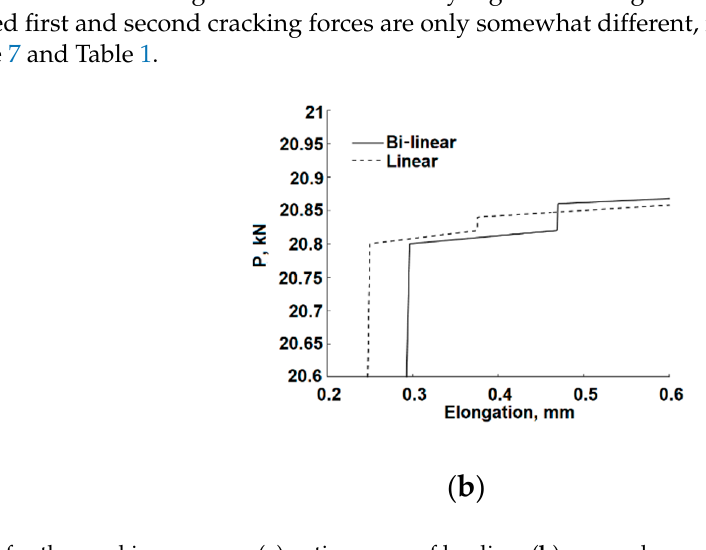
Figure 10. Bar elongation for the cracking process. ( a ) entire range of loading; ( b ) zoomed zone of first and second cracks initialization.